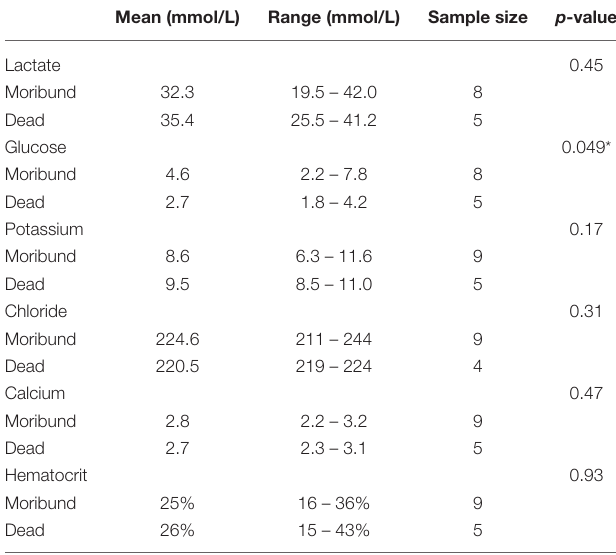
TABLE 2 | Physiological comparisons between sharks classified as “moribund” and